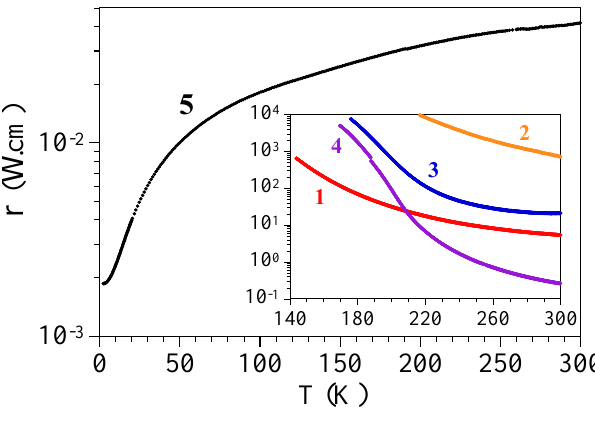
Figure 6. Thermal variation of the dc electrical conductivity of compounds 1 – 5 .